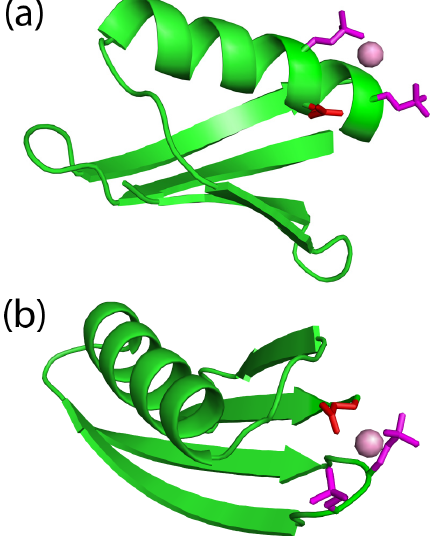
Figure 5. An additional glutamate residue acts as a helper residue to bind a lanthanide ion in double-phosphoserine mutants of GB1. (a) GB1 A24Sep/K28Sep with the side chains of the phosphoserine residues (purple) and Glu26 (red) modelled to indicate their possi- ble proximity to a lanthanide ion (purple ball). A side-chain oxy- gen of Glu26 (in the conformation of the crystal structure 1PGA; Gallagher et al., 1994) is within 4.9Å of the metal ion. (b) GB1 K10Sep/T11Sep showing the phosphoserine side chains in purple and Glu56 in red. Using the side-chain conformation of Glu56 in the crystal structure, a carboxylate oxygen is within 3.6Å of the metal